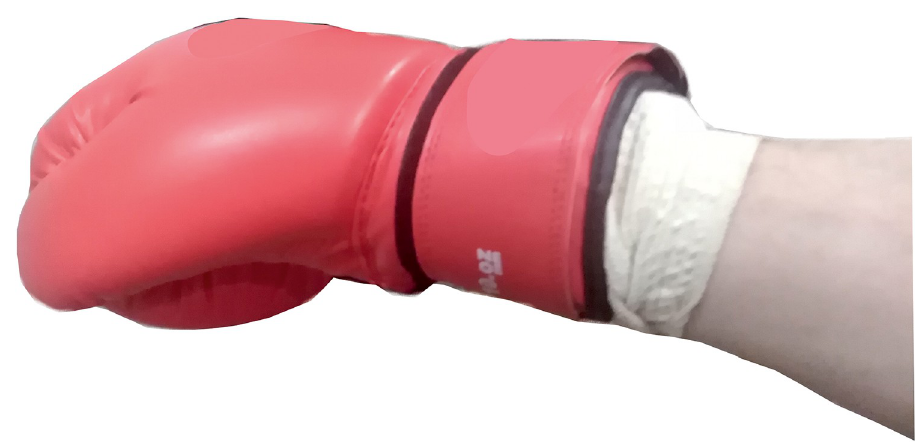
Fig 4. Boxing glove with measuring